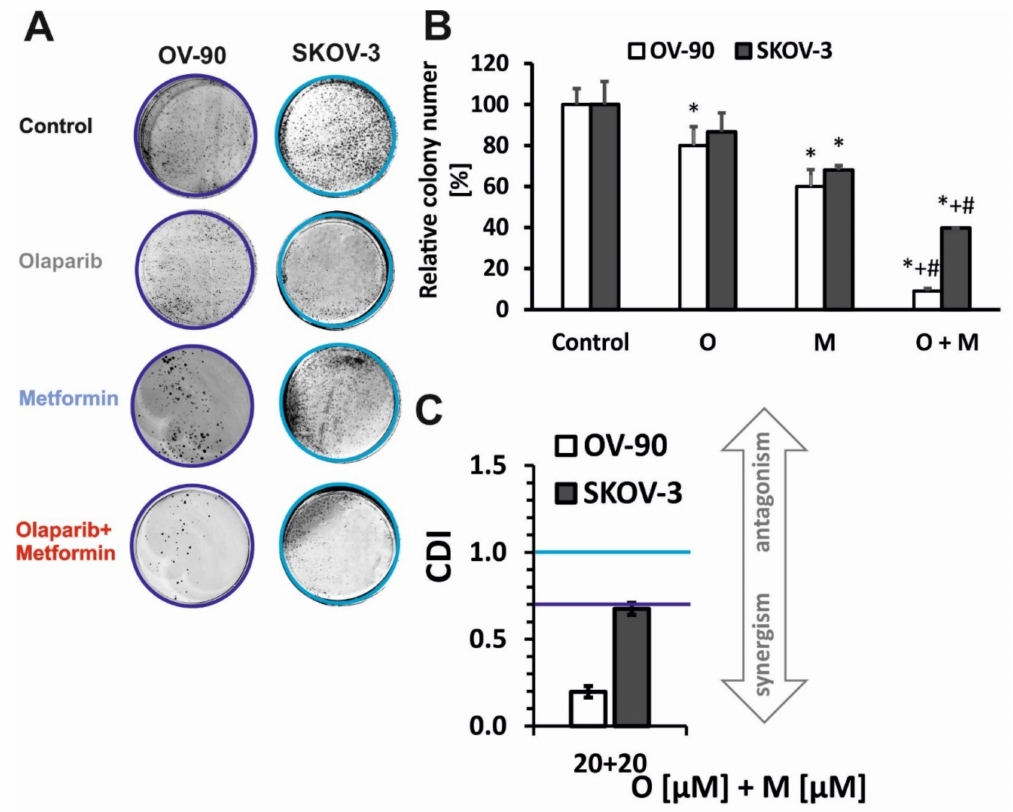
Figure 2. Prolonged incubation with metformin in combination with olaparib decreased colony numbers ( A , B ). Colony formation was evaluated following treatment with 20 µ M olaparib, 20 mM metformin, or combination treatment with olaparib (20 µ M) and metformin (20 mM) in SKOV-3 and OV-90 cells. ( C ) Drug interaction analysis based on colony formation assay. Data represent the mean ± SD of three biologic assays. * p < 0.05 for olaparib, metformin, or a combination of both drugs vs. control cells; # p < 0.05 for olaparib vs. combination (O + M); + p < 0.05 for metformin vs. combination (O +